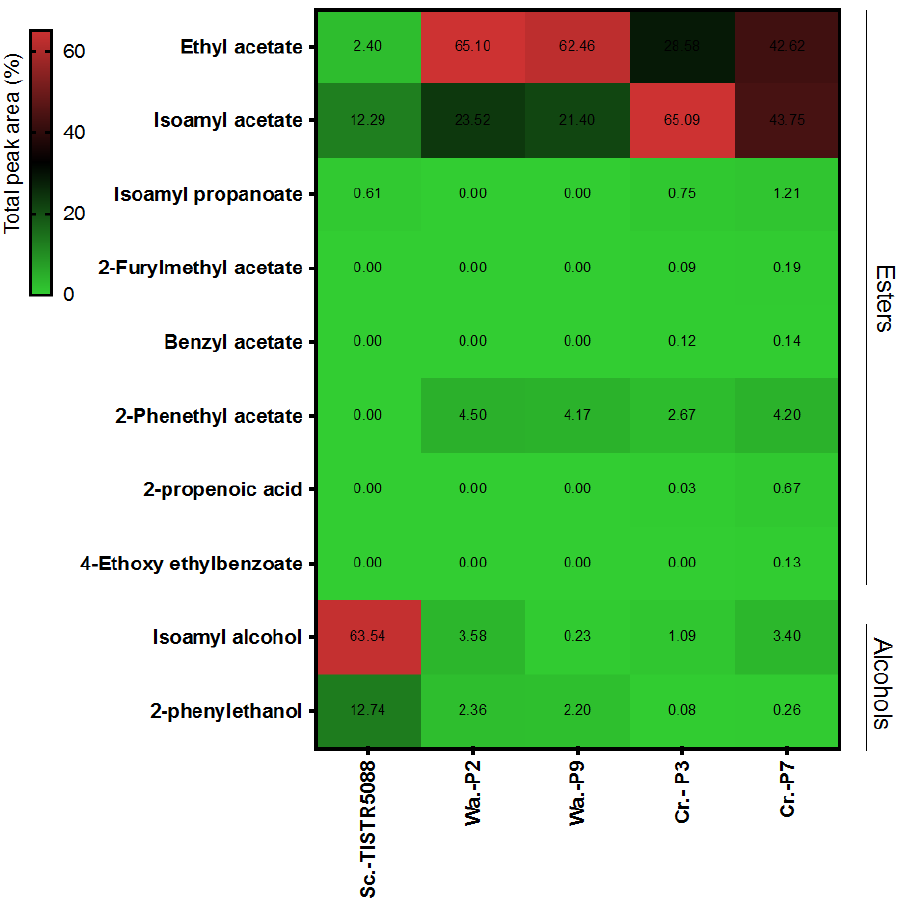
Figure 4. Heatmap using the total peak area (%) of VOCs produced with S. cerevisiae TISTR 5088, W. anomalus (P2, P9) and C. rhodanensis (P3, P7) on YM agar at 30 °C for 2 days.